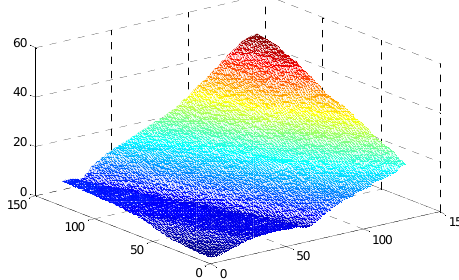
Figure 2 . Hilly test reference area, 128 x 128 grid, 25 cm spacing, 3x vertical